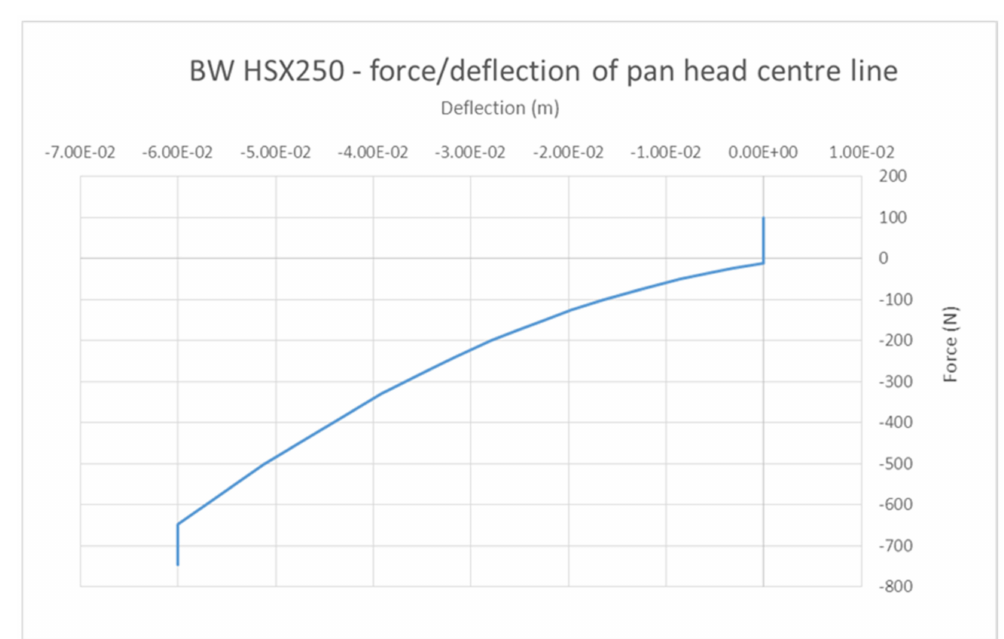
Figure 10. Implementation of non-linear pantograph head stiffness of HSX250 pantograph, showing also bump stops.